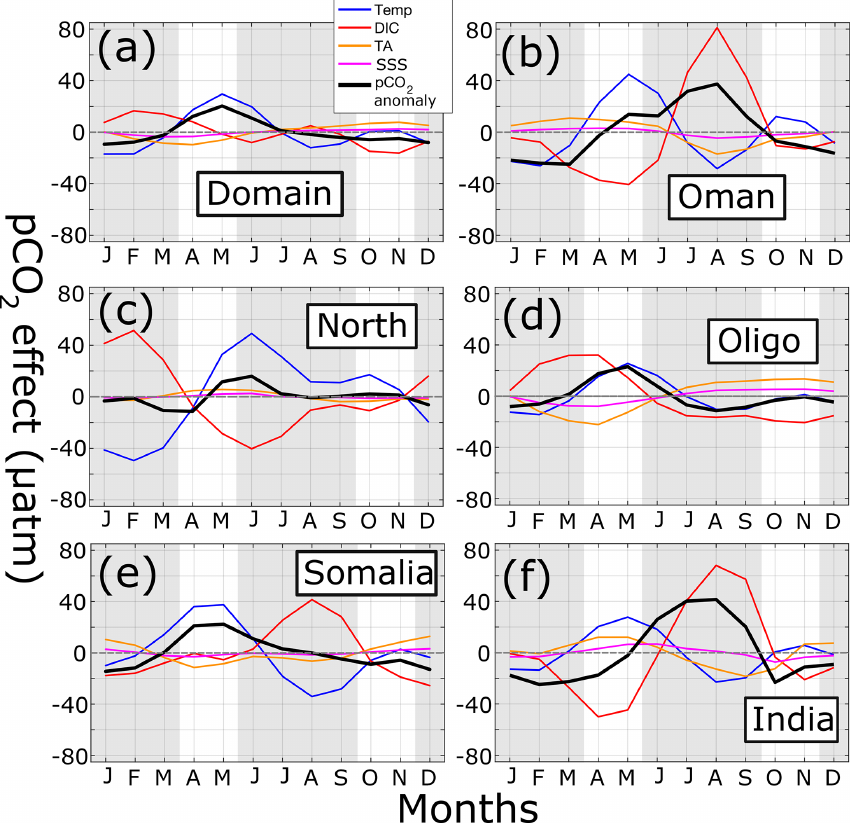
Figure 11. Time series of p CO 2 anomalies (µatm) (black lines) for (a) the entire domain, (b) Oman, (c) north AS, (d) oligotrophic central AS, (e) Somalia, and (f) India. Dashed gray lines indicate horizontal axis. Gray shading shows summer and winter monsoons. Additional lines show change in p CO 2 due to temperature (blue), DIC (red), TA (orange), and SSS